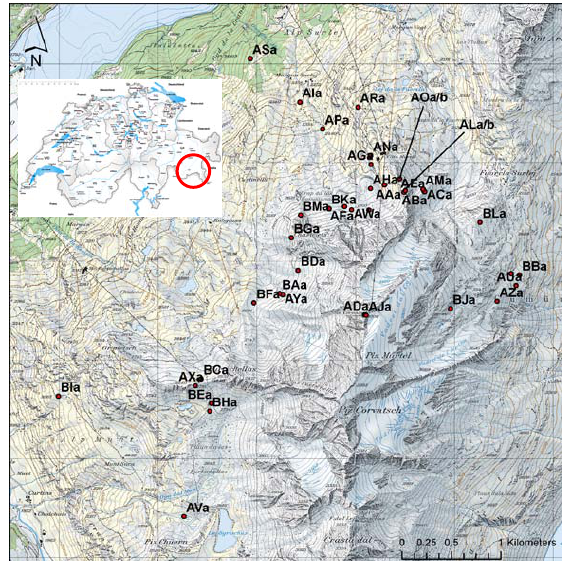
Fig. 1: Research area around Piz Corvatsch (South-eastern Switzerland) with locations 2 Fig. 1. Research area around Piz Corvatsch (south-eastern Switzer- land) with locations of all footprints. of all footprints. 3